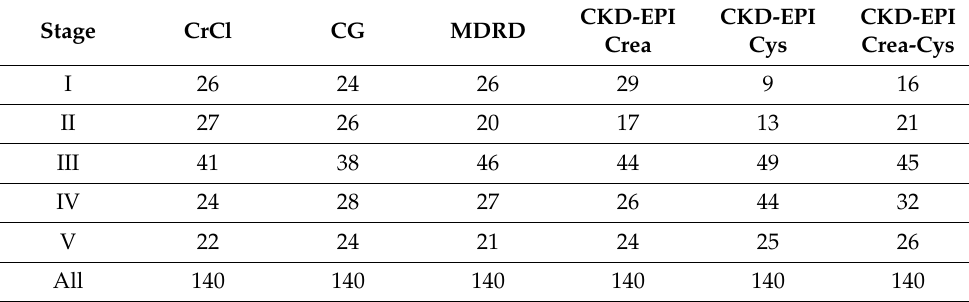
Table 3. The number of patients at different stage CKD by method